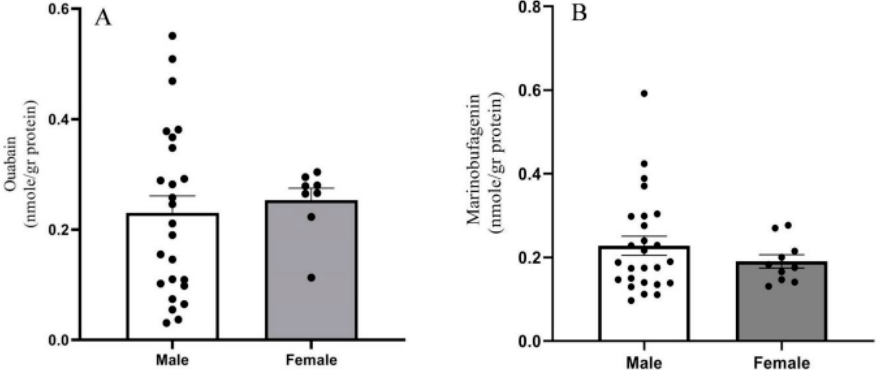
Figure 3. Endogenous OUA- and MBG levels in PFC in men and women . OUA ( A ) and MBG ( B ) immuno-reactivity levels in the postmortem PFC of all samples assayed were determined with DELFIA, as described in the materials and methods. Bars represent the means; error bars represent the standard error of the means.